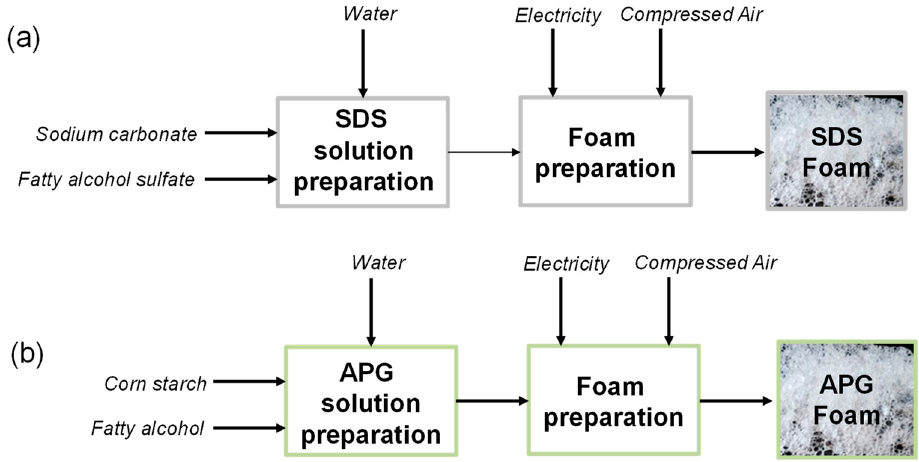
Figure 9. The process flowchart for the foam cleaning process formulated with: ( a ) SDS and ( b ) APG.